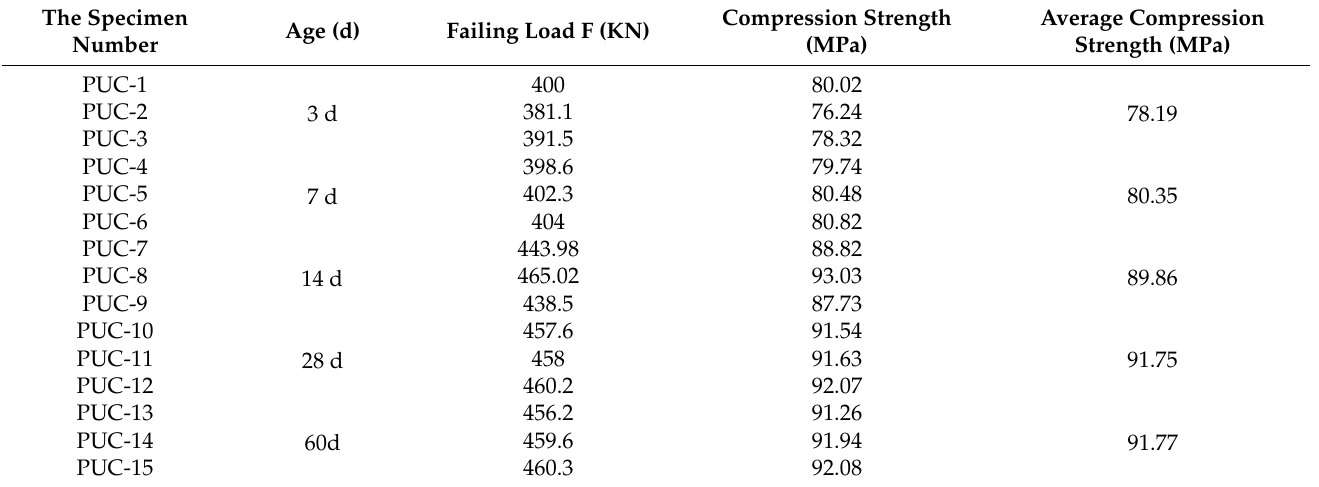
Table 5. Record table of compressive strength test results of cube specimens at standard